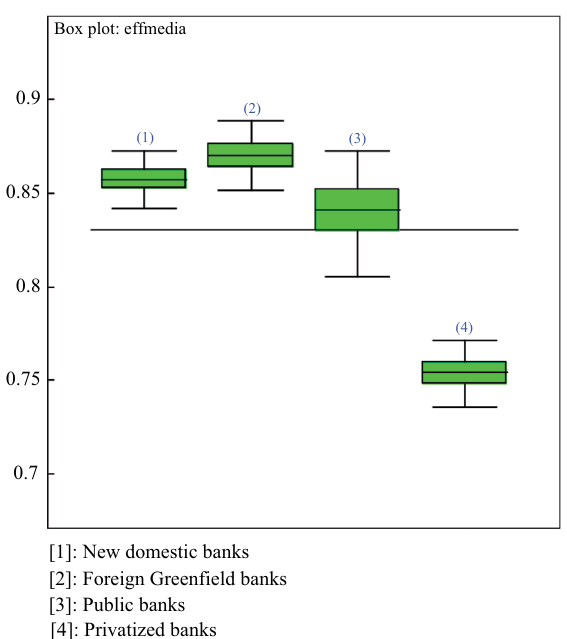
Fig. 2. Boxplot of the posterior distribution of the mean profit bank efficiency classified according to its type of ownership without distinguishing presence/ absence of a foreign strategic owner and using the truncated normal